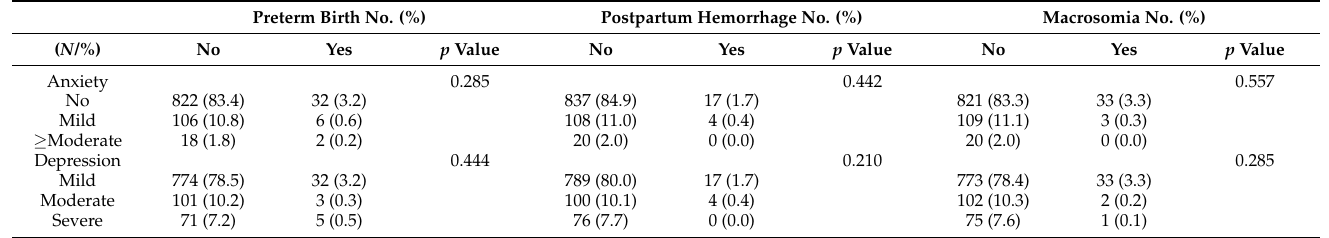
Table 4. The relationship among anxiety, depressive symptoms, sleep status and pregnancy